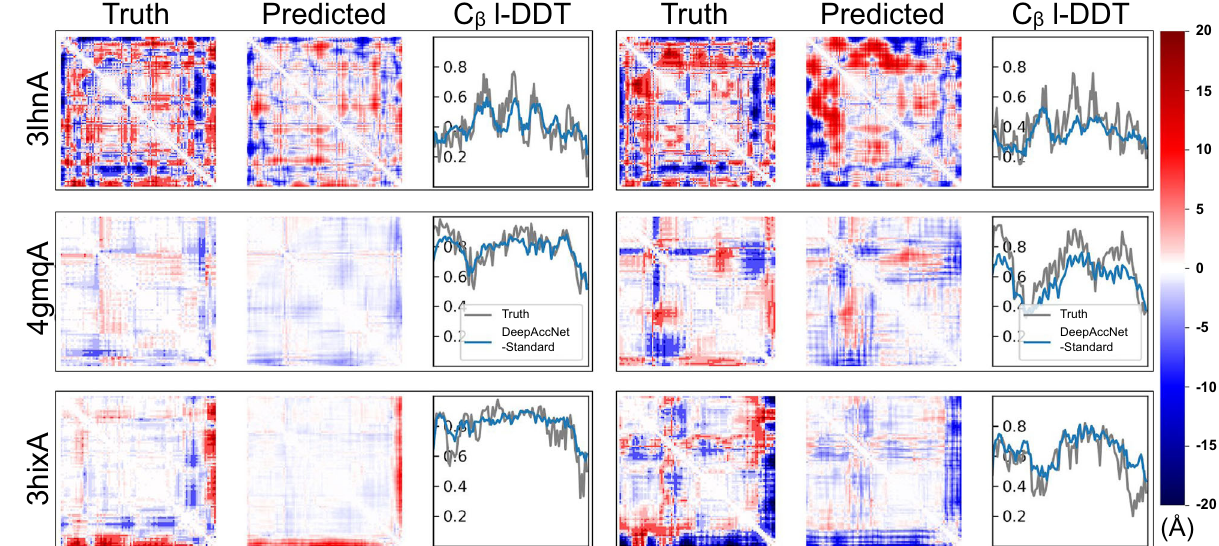
Fig. 2 Example estograms and C β l-DDT score prediction. DeepAccNet-Standard predictions for two randomly selected decoys for three test proteins were randomly selected (3lhnA, 4gmqA, 3hixA; size 108, 92, and 94, respectively; black rectangular boxes delineate results for single decoy). The fi rst and fourth columns show true maps of errors, the second and fi fth columns show predicted maps of errors, and the third and sixth columns show predicted and true C β l-DDT scores. The i, j element of the error map is the expectation of actual or predicted estograms between residues i and j in the model and native structure. Red and blue indicate that the pair of residues are too far apart and too close, respectively. The color density shows the magnitude of expected are considerably better on average for almost all the test set proteins (Supplementary Fig. 2a; Fig. 3); they outperform the